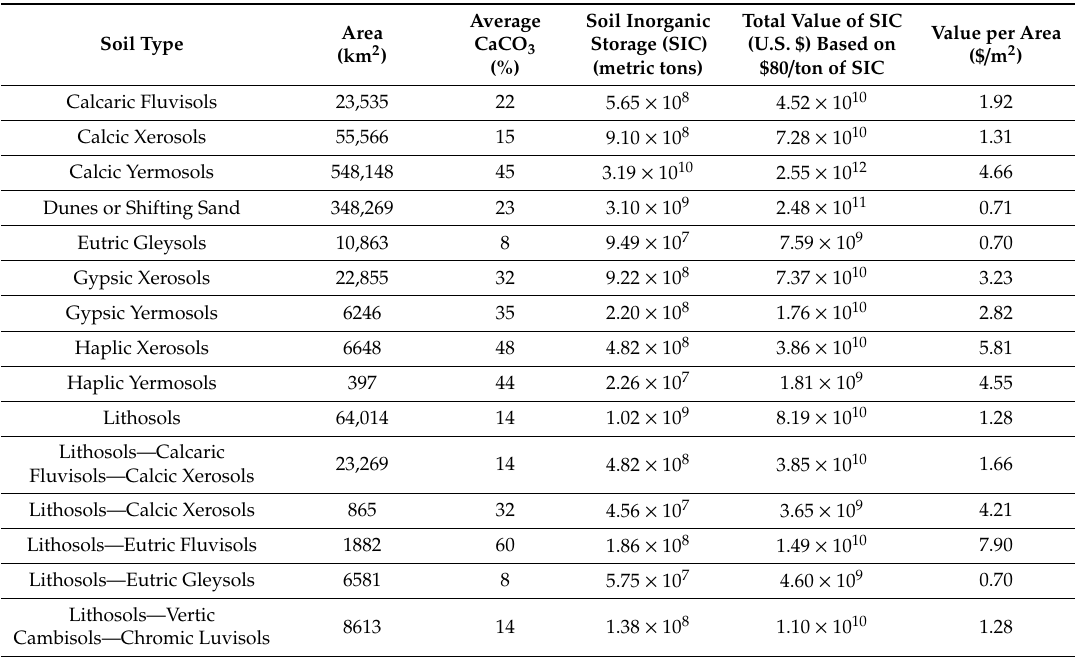
Table 9. Soil inorganic carbon (SIC) storage in Libyan soils and the SIC value based on the avoided social cost of CO 2 emissions following